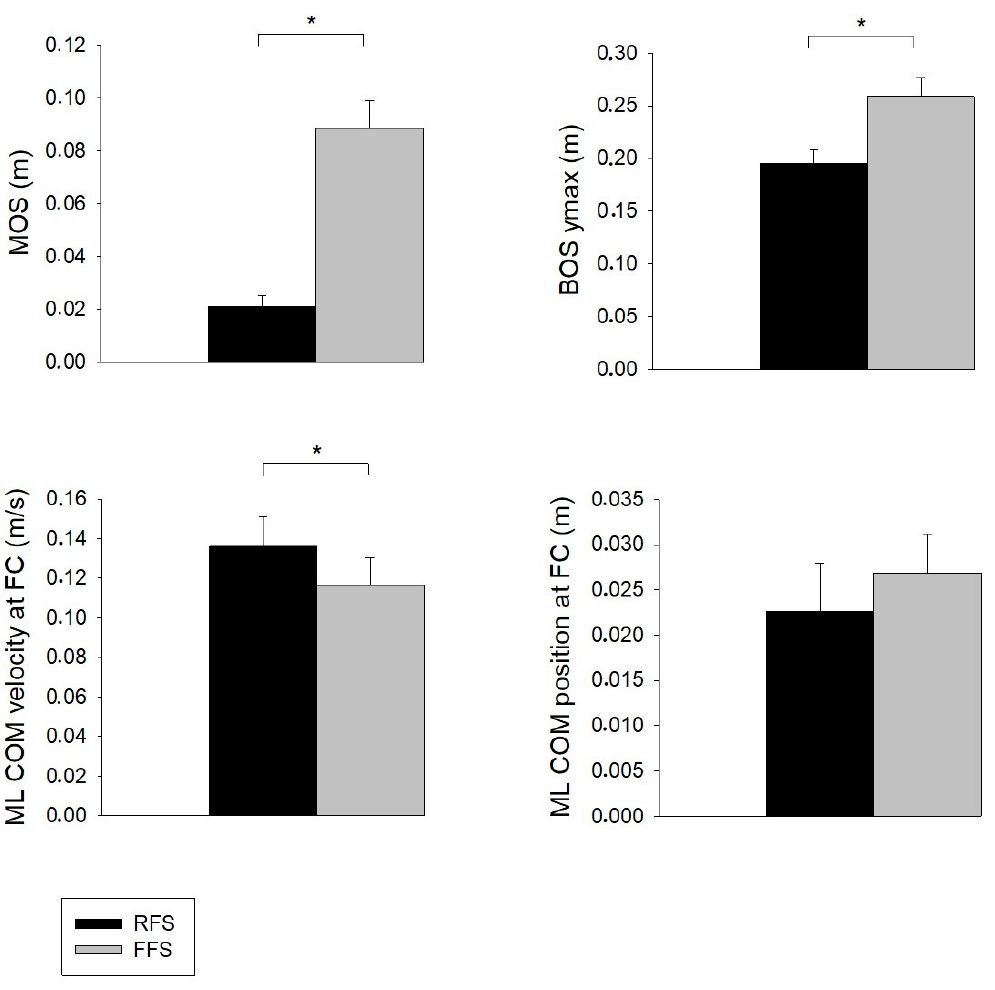
Figure 5. Effects of swing-foot strike pattern on selected stability parameters along the mediolateral (ML) direction. Reported are mean values (all participants together) + 1 SE. BOSymax: base of support size; MOS: margin of stability; COM: centre of mass; RFS: rearfoot strike condition; FC: swing foot contact; FFS: forefoot strike condition. * Indicates a significant difference between bars.